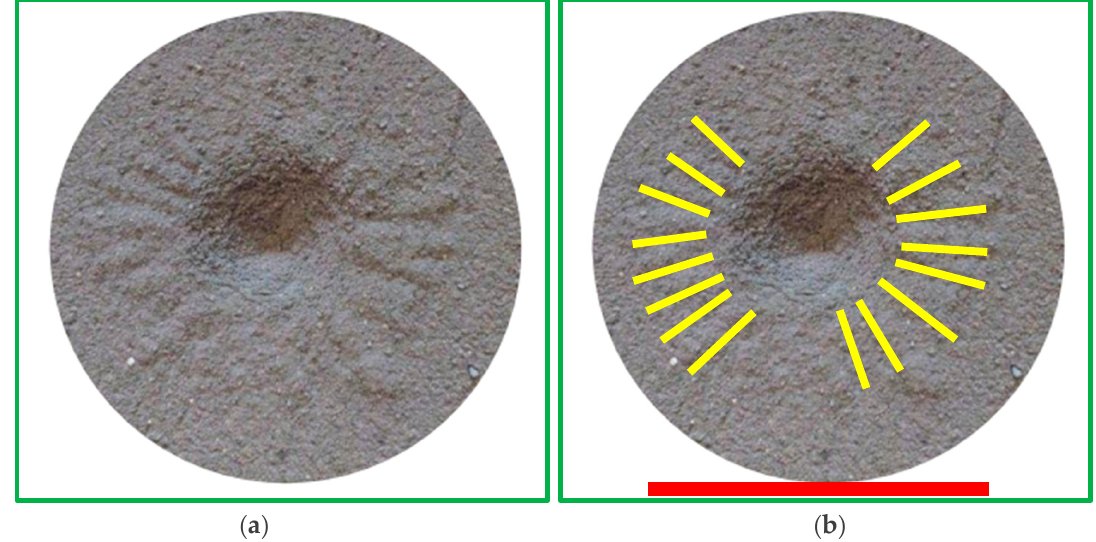
Figure 3. ( a ) Crater resulting from low kinetic energy impact on DNA-1A; ( b ) sketch of the ray system (in yellow); the outer diameter of the crater (see the red bar) is about 7 cm.